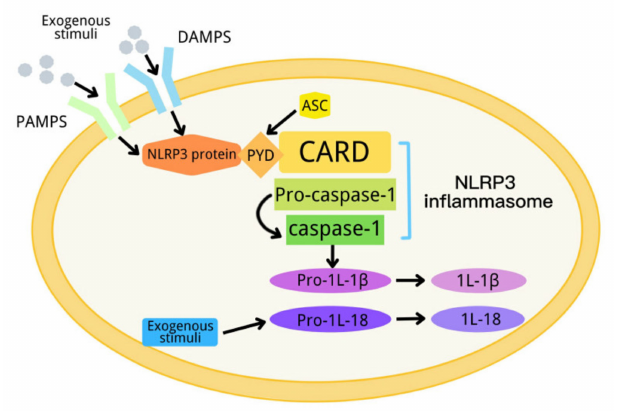
Figure 1. Schematic diagram of the NLRP3 inflammasome activation process.